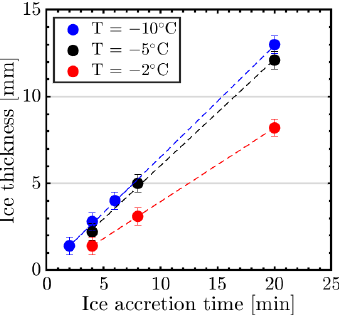
Figure 10. Ice thickness over ice accretion time at different temperatures.